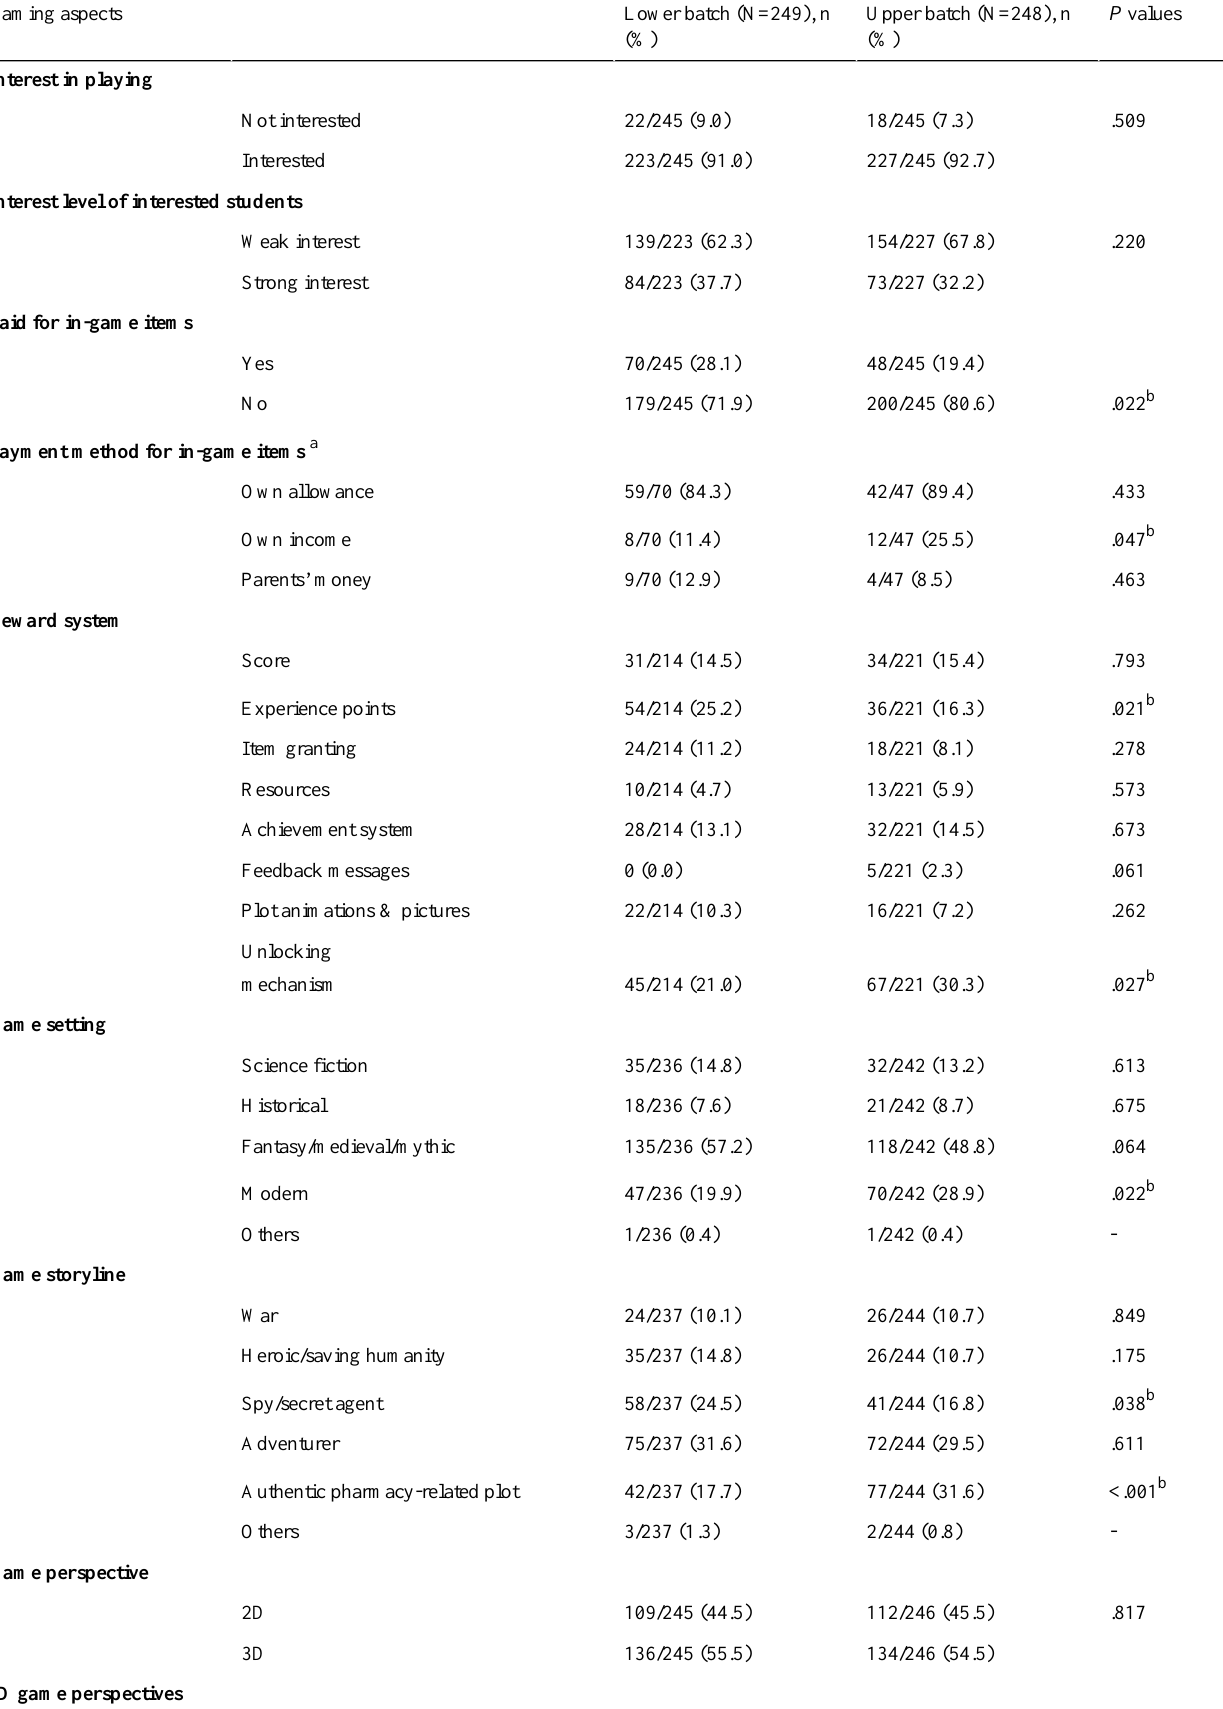
Table 3. Comparison of gaming aspects by year of